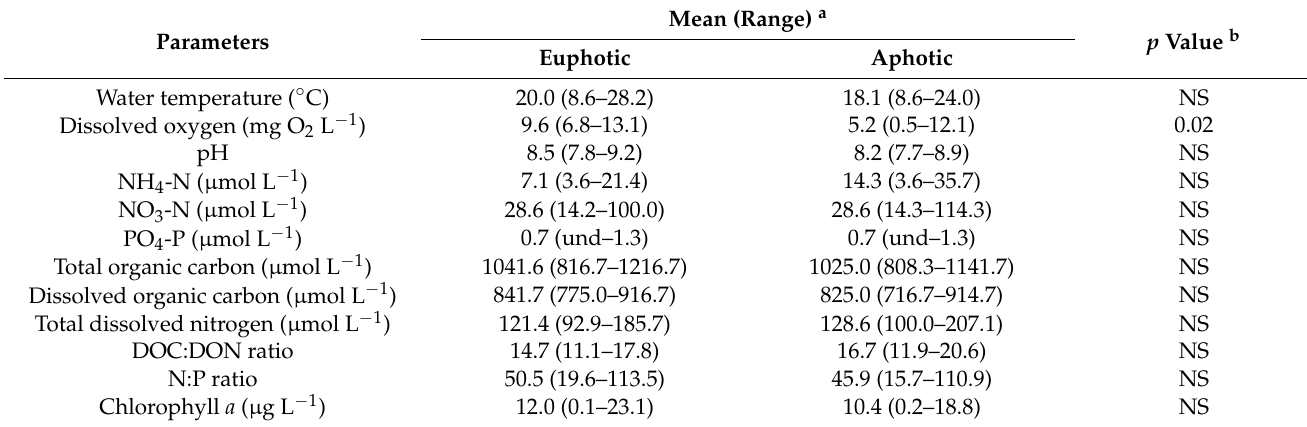
Table 2. Physico-chemical characteristics of Lake Goule at the studied